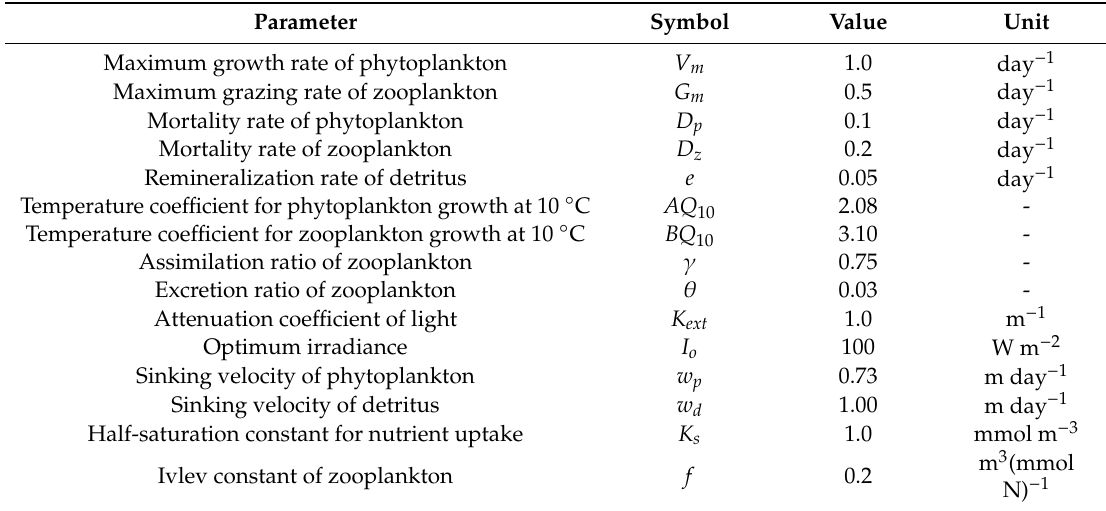
Table 1. Ecological parameters and their values in the